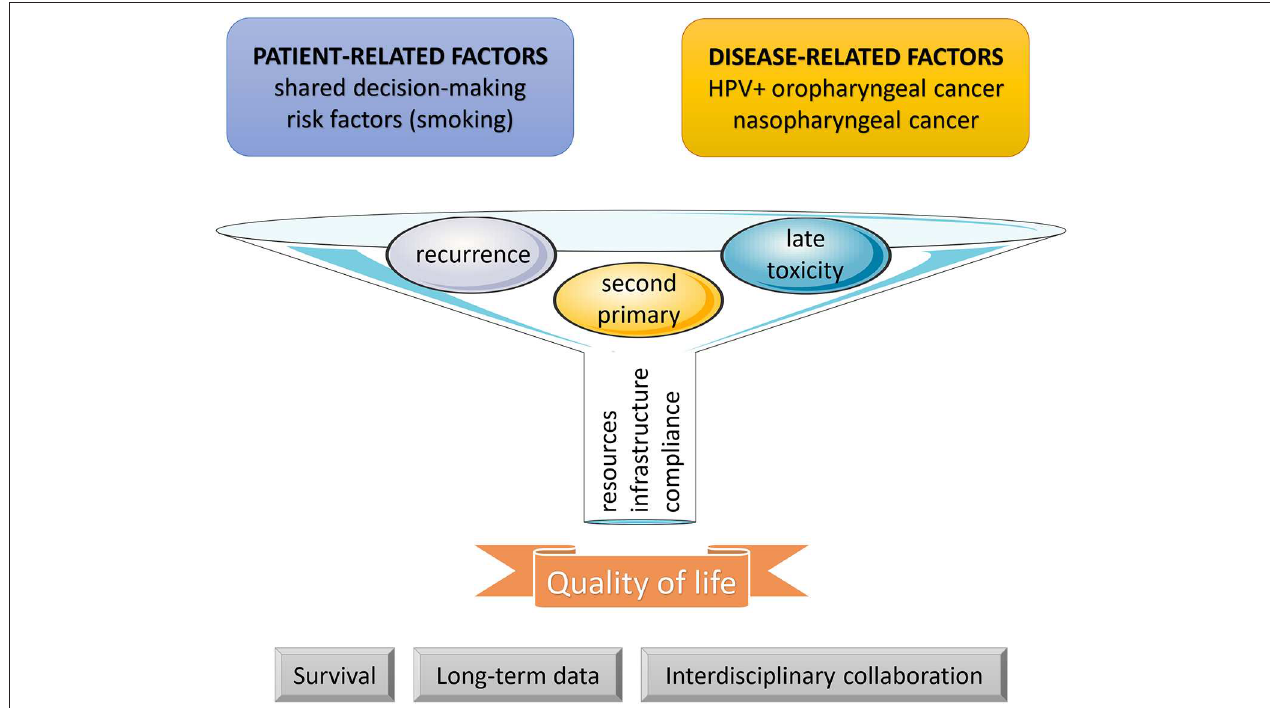
FIGURE 1 | Follow-up funnel. During the post-treatment phase, surveillance is indicated in all cancer patients. As defined by patient- and disease-related factors, a more intensive approach may be considered. In head and neck cancer survivors, the three main goals of surveillance include an early detection and management of recurrences, second primary tumors, and late adverse events. The results depend on patient compliance and available resources and infrastructure. Until present, improvement in quality of life has remained the strongest outcome, and further efforts are needed to clarify the impact on survival, to collect sufficient evidence from long-term data, and to structuralize interdisciplinary collaboration between all professional stakeholders.